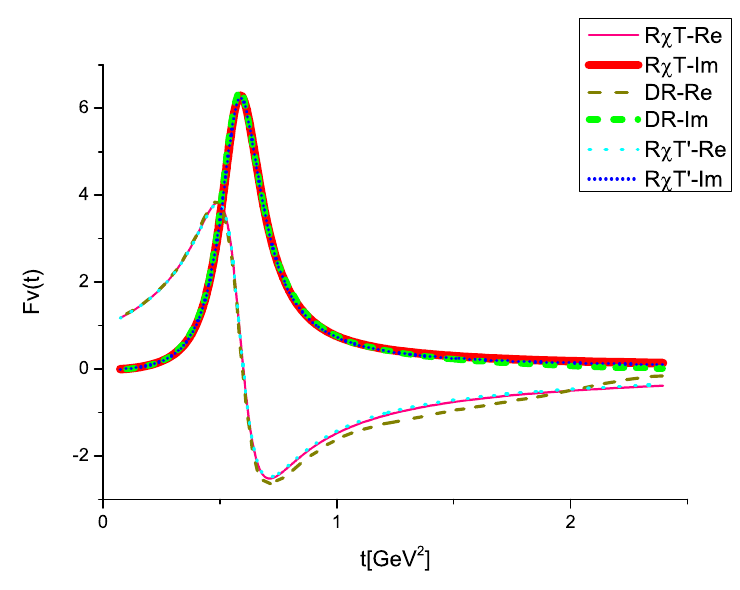
Figure 4 . The real (Re) and imaginary (Im) parts of the pion vector form factor F V ( t ) . The curves labeled as R χ T are taken from the full amplitudes from ref. [16], while the symbol R χ T’ refers to removing the two-kaon channel from the full amplitudes. The dispersive results of ref. [17] are denoted as DR